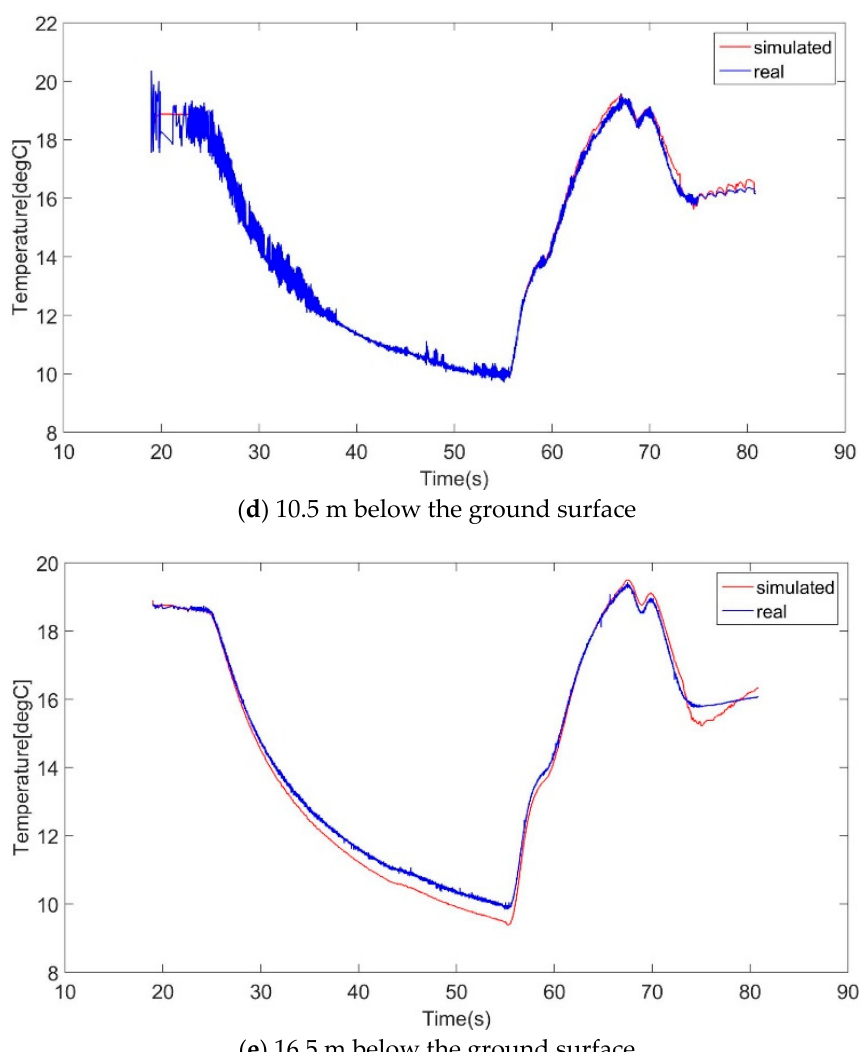
Figure 12. Temperature profiles in the borehole when the heat transfer coefficient across the concrete–soil surface was 6 W/m 2 K.